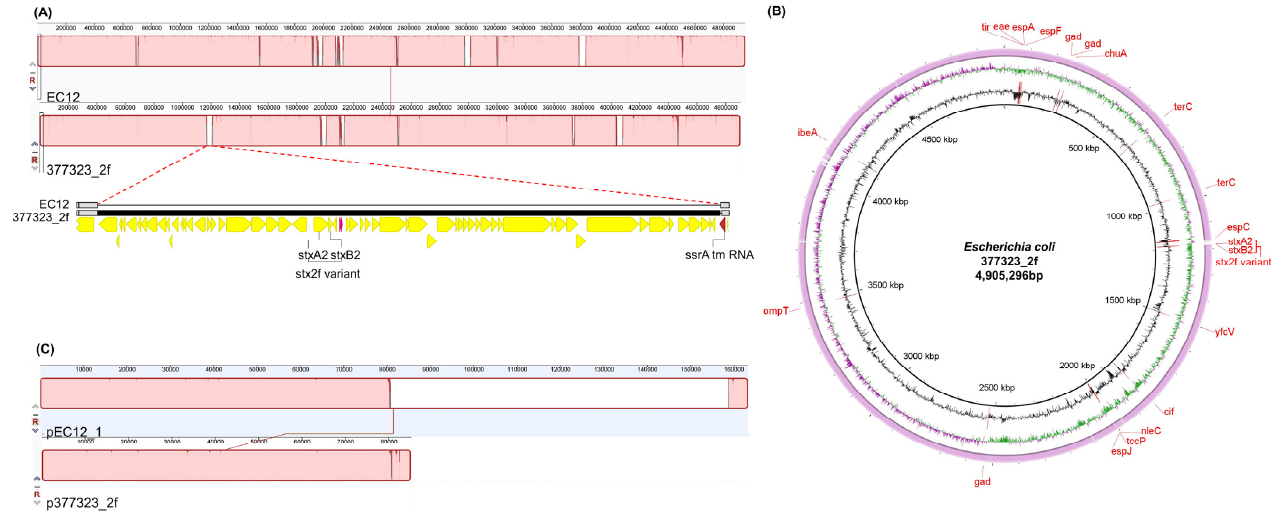
Figure 3. Genome comparison of strains EC12 and 377323_2f. ( A , B ) Chromosome comparisons using Mauve ( A ) and BRIG ( B ) demonstrate a gap of around 42.5 kbp in EC12 corresponding to the stx -harboring prophage sequence. ( C ) Plasmid alignment using Mauve shows that pEC12_1 contains the whole sequence of p377323_2f. In Mauve, identically colored boxes represent homologous regions shared by the aligned genomes.